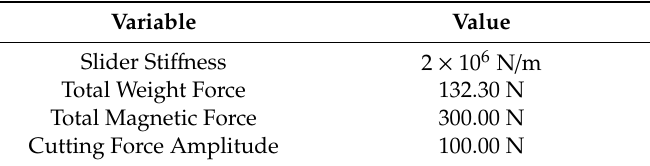
Table 2. Values of the variables of interest of the model.